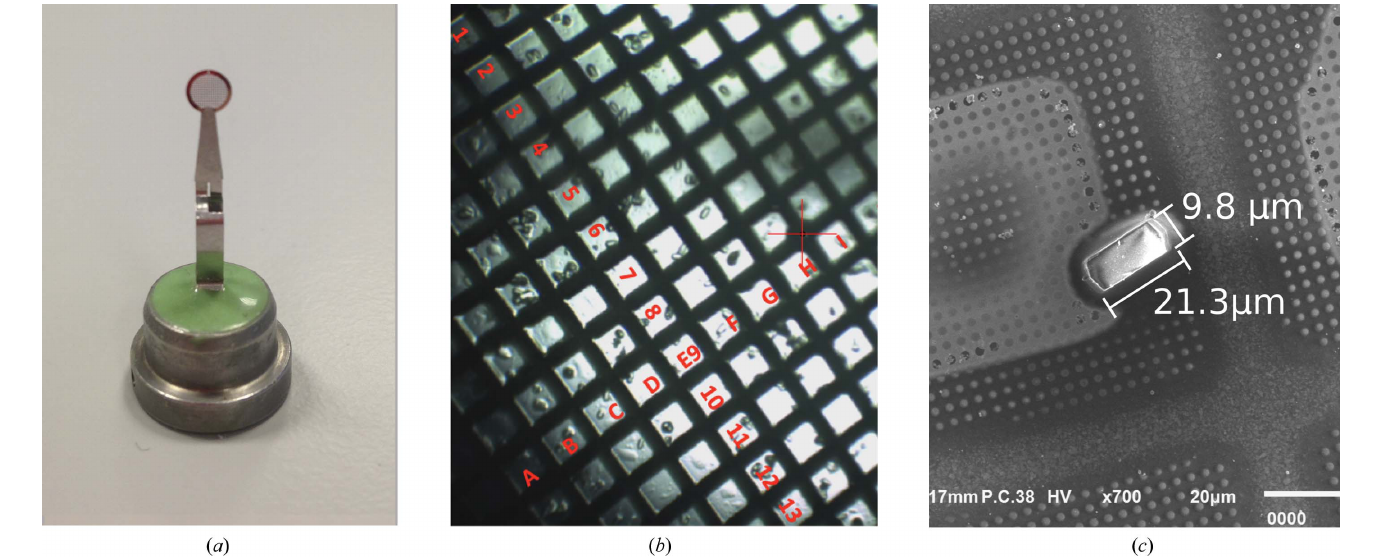
Figure 1 ( a ) A cryo-TEM grid held on a tweezer pin. ( b ) A cryo-TEM grid viewed in the on-axis viewing microscope overlaid with the coordinate system used to identify crystals in the scanning electron microscope (SEM) post X-ray exposure. ( c ) SEM image of HEWL crystal dimensions being